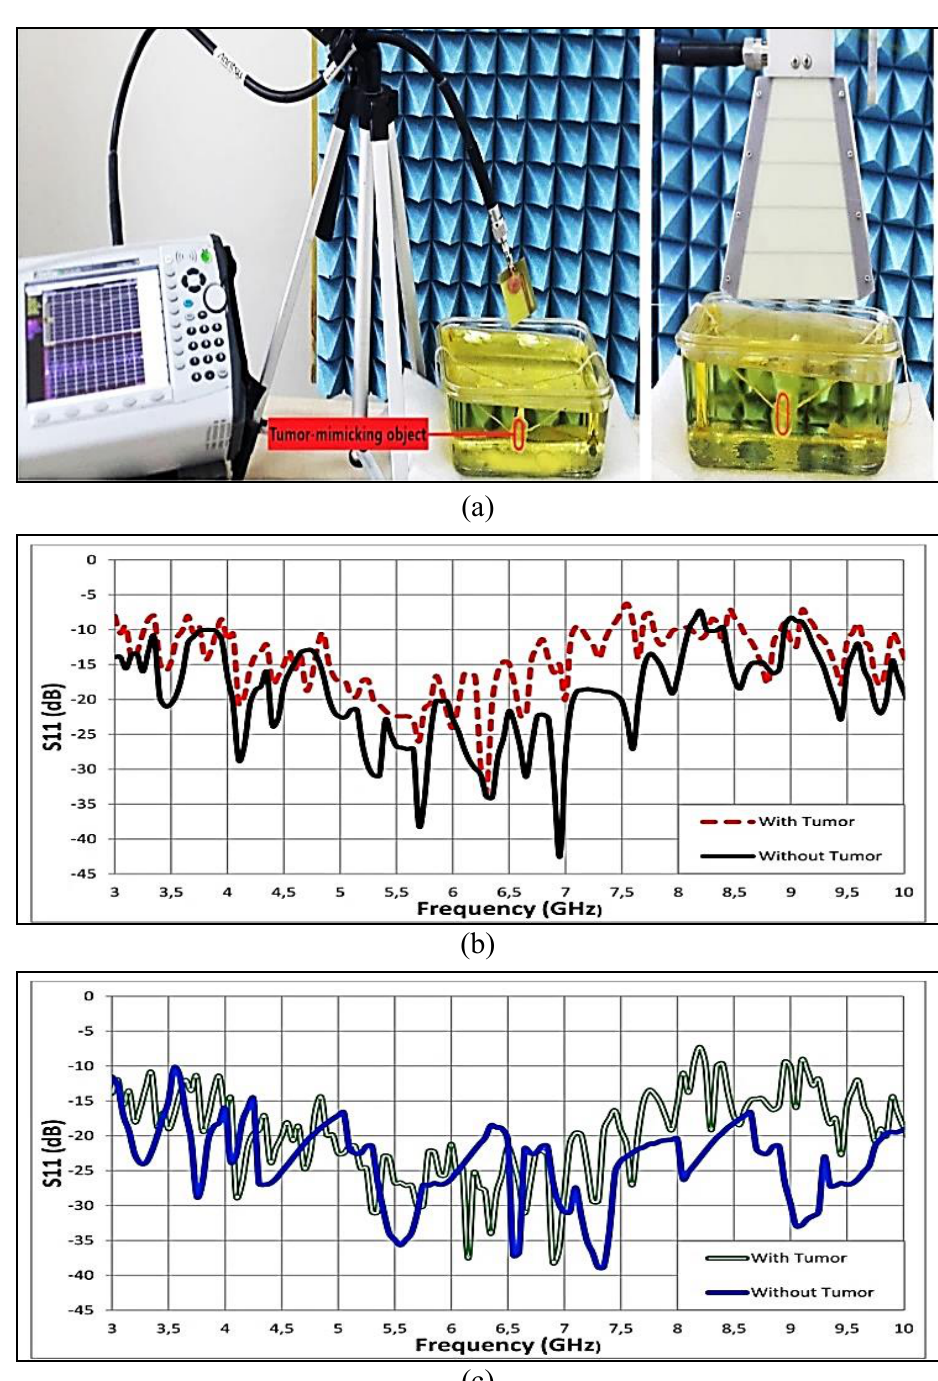
FIGURE 5. Experimental